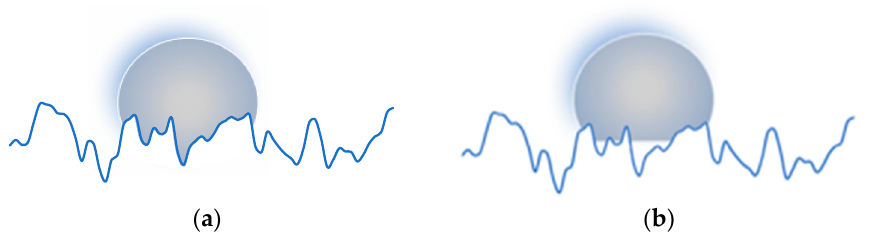
Figure 8. ( a ) Scheme of the Wenzel model and ( b ) Cassie–Baxter model applied to a random surface. Wenzel and Cassie–Baxter models are reported in the Equations (1) and (2), respectively.